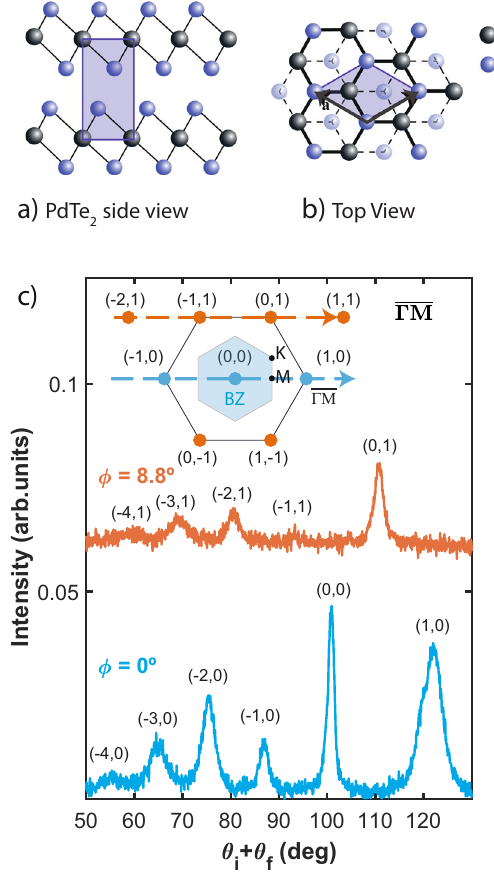
Fig. 1 Structural characterization of PdTe 2 by HAS. a Side and b top views of the PdTe 2 crystal structure. c In-plane and out-of- plane (blue and orange curves, respectively) He diffraction spectra from 1T-PdTe 2 along Γ M measured with an incident angle of 50 ∘ . The incident energy is E i = 49.5 meV and the surface temperature is T = 90 K. The inset in ( c ) shows the PdTe 2 lattice in reciprocal space. Orange and blue colored spots are diffraction peaks, and blue shaded area is the Brillouin zone